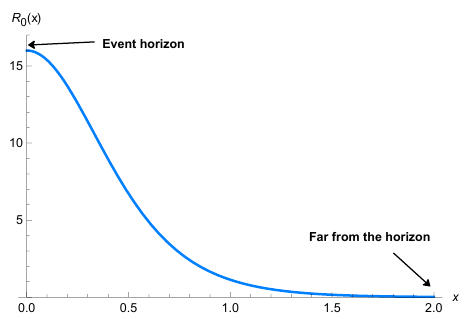
Figure 1 . The behavior of the scalar curvature R 0 , where λ = 4 and x ≥ 0 .